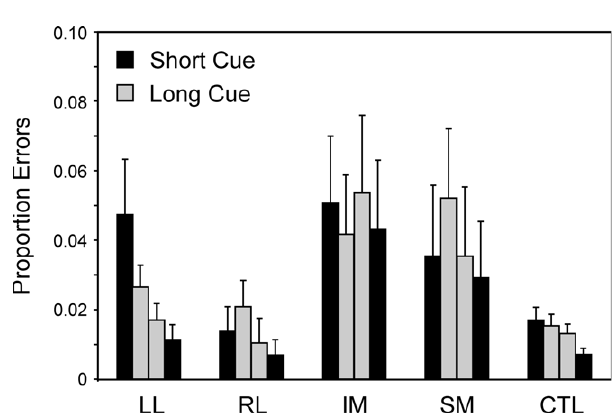
Figure 7. Error rates. Mean error rates (with standard errors of the mean) of the four patient groups and the controls on Repeat and Switch trials in the Long Cue and Short Cue task conditions.